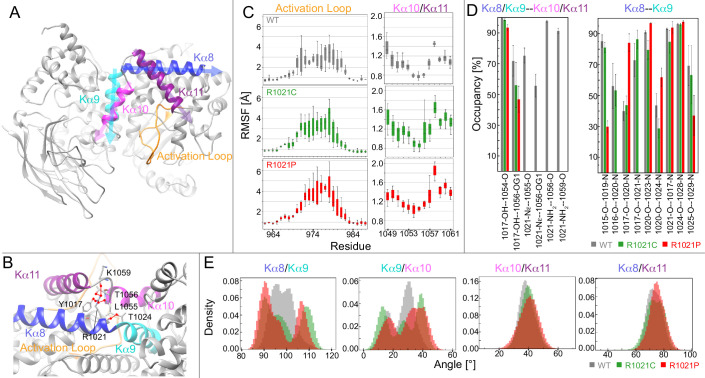
Molecular dynamic simulations reveal that the R1021C and R1021P mutations show increased instability in p110γ.(A) Model of p110γ showcasing the regulatory domain’s kα8 (995–1023), kα9 (1024–1037), kα10 (1045–1054), and kα11 (1057–1078) helices, and the activation loop (962-988). (B) A zoomed-in snapshot of R1021 microenvironment showing residues in licorice. Hydrogen bonds with R1021 are drawn as red lines. (C) RMSF [Å] of each residue’s Cα and Cβ atoms in the activation loop and the kα10/kα11 helices, respectively. RMSF values for each atom across replicates are shown as a quantile plot, with error shown as standard deviation (n = 3). (D) The mean and standard deviation of hydrogen bond occupancies between the indicated helices/sets of helices across replicates (n = 3). (E) Inter-angle density distributions across all replicas between kα8, kα9, kα10, and kα11. In all panels, WT, R1021C, and R1021P are coloured in grey, green, and red, respectively.